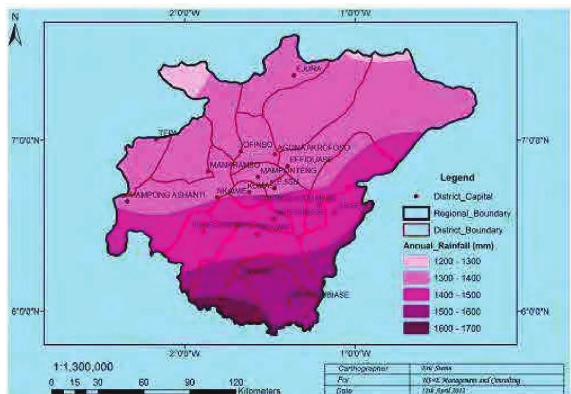
Figure 5: Average annual rainfall in the Ashanti Region (source: https://openjicareport.jica.go.jp/pdf/1000014018_01.pdf).